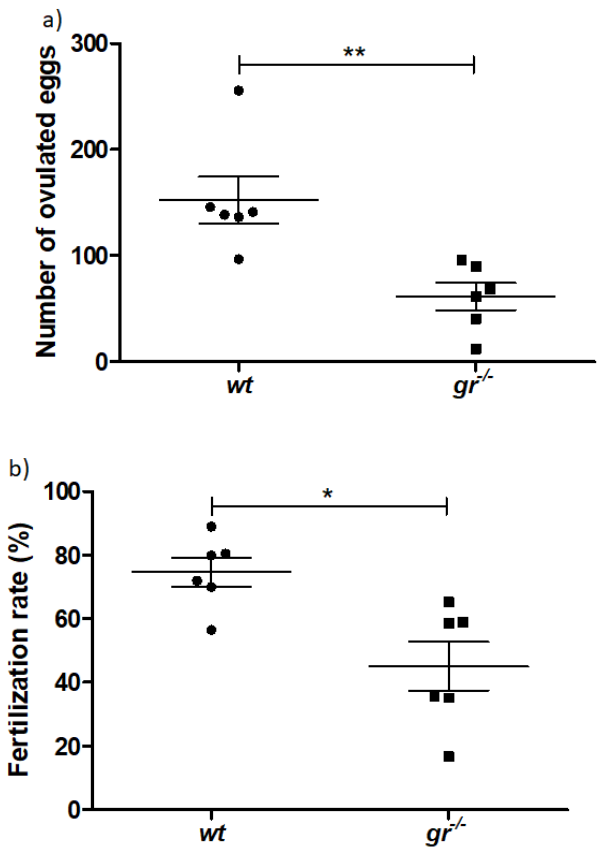
Figure 2. Fish fertility ( a ) number of eggs laid by wt females crossed with wt males (black circle dots) and gr − / − females crossed with wt males (black square dots); ( b ) fertilization rate in wt and gr − / − females. Asterisks denote statistical significant differences (* p < 0.05; ** p < 0.01).